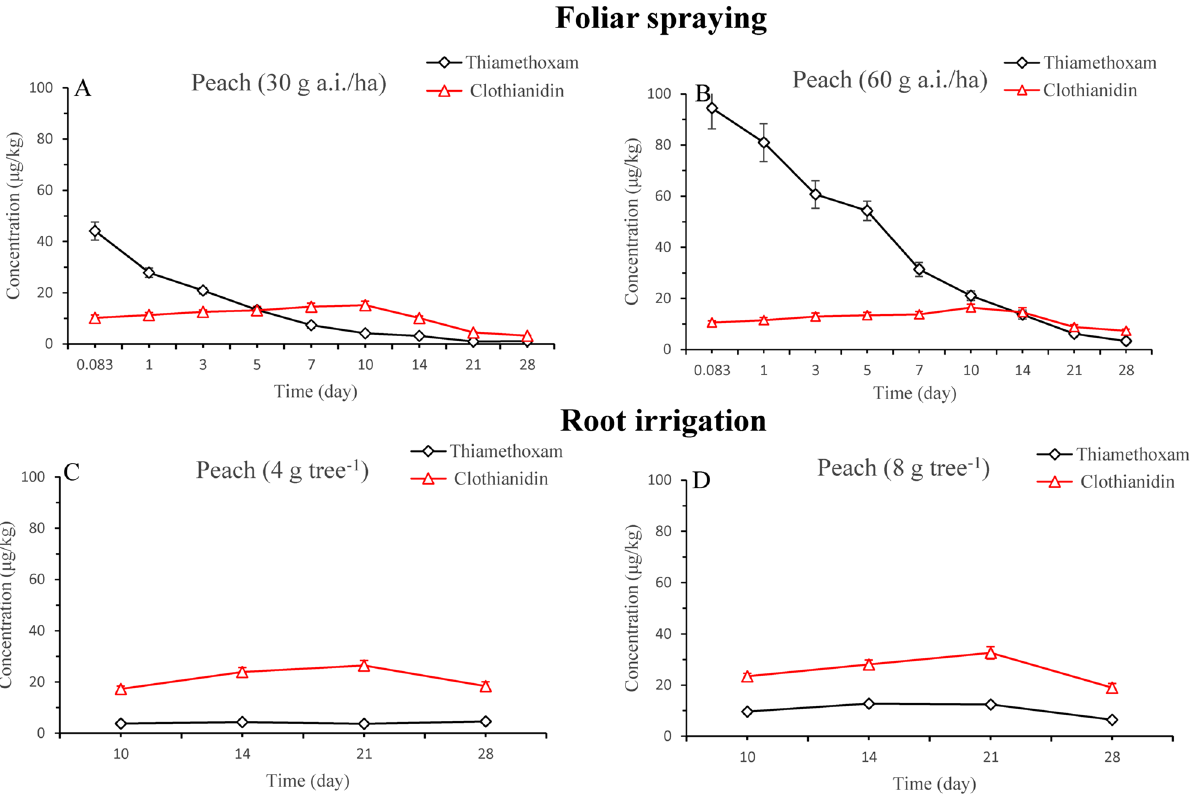
Figure 2. Residues of thiamethoxam and clothianidin in peaches after application by foliar spraying at standard ( A ) and 2 times ( B ) dose treatments and by root irrigation at 4 g tree −1 ( C ) and 8 g tree −1 ( D ).